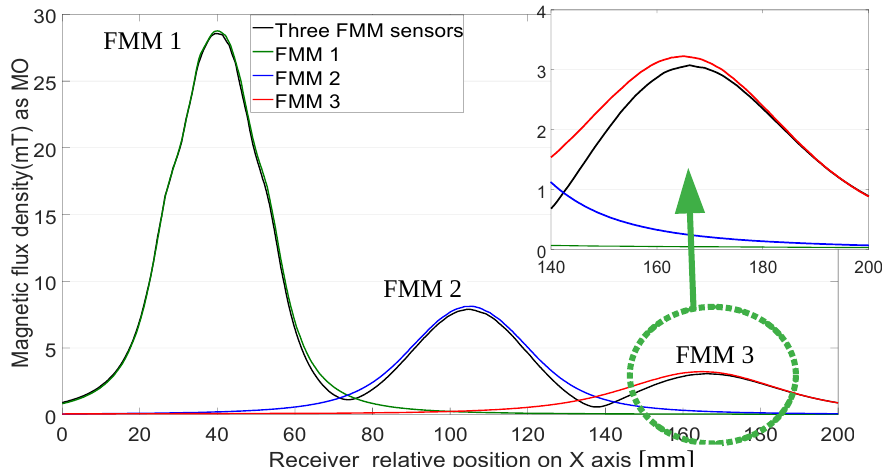
Figure 14. Numerical model of Configuration 3: MO for each FMM tool independently vs. MO from all three tools with reactive-part dimensions of 25 mm × 25 mm × 1 mm in the presence of rebar. The result of MO variations from the three tools relative to reactive-part thickness increasing from 0 to 1 mm in the presence of rebar is illustrated in Figure 15. The inverse relationship between MO variations and increasing reactive-part thickness still agrees with the previous results in Configuration 2. Moreover, the maximum MO value associ- ated with the first tool, FMM1, indicates a declining trend from 54 mT to 29 mT as the reactive-part thickness increases from 0.2 mm to 1 mm. The value for FMM3, the tool closest to the rebar, falls from 3.51 mT to 3.02 mT. For this particular tool, which is slightly more heavily affected by the coupling effect, the percentage of relative attenuation is increased from 22% to 35%; however, this value for Configuration 2 (without rebar) rises from 20% to 34%. Lastly, to include the minimum MO level as obtained by the external receiver during the simulations, it is possible to consider the Signal-to-Noise (S/N) ratio = 20 dB for White Gaussian Noise (WGN) as a reference. The minimum MO is ultimately approx. +/ − 0.1 T, which can be assumed as a detectable threshold in